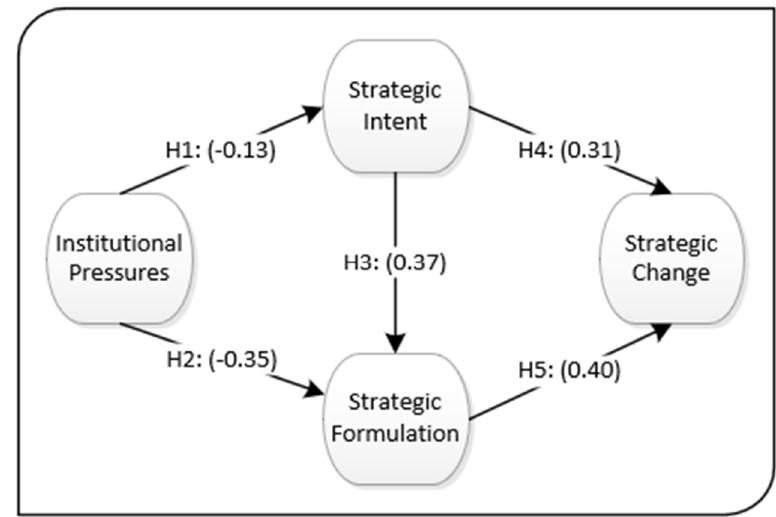
Figure 2. SEM path analysis results. Table 7. Hypotheses testing results.